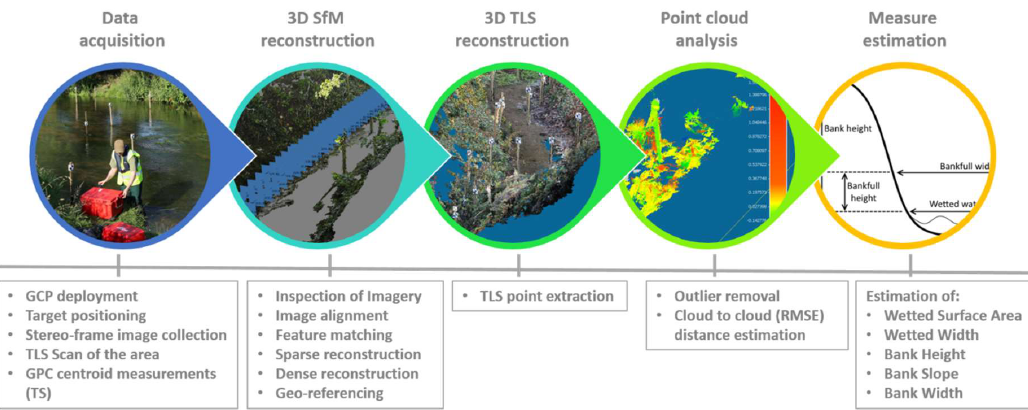
Figure 5. Workflow depicting the main steps followed to estimate the selected hydromorphological measures. Implementation of the workflow requires Photoscan Pro version 1.1.6 (Agisoft LLC, St. Petersburg, Russia), CloudCompare v2.6.1 (GPL Software) and bespoke Python scripts. The abbreviations stand for: Ground Control Point (GCP), Total Station (TS), Terrestrial Laser Scanner (TLS) and Root Mean Square Error (RMSE) of distance measurements.